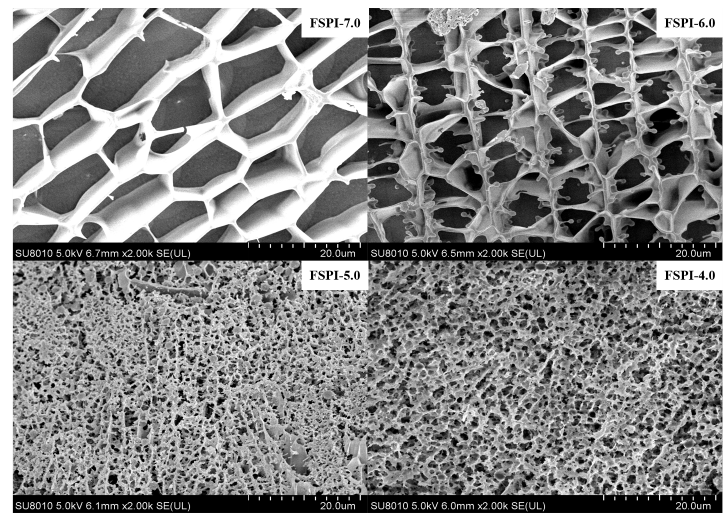
Figure 3. Cryo-EM microstructure of FSPIs at varied levels of terminal pH.